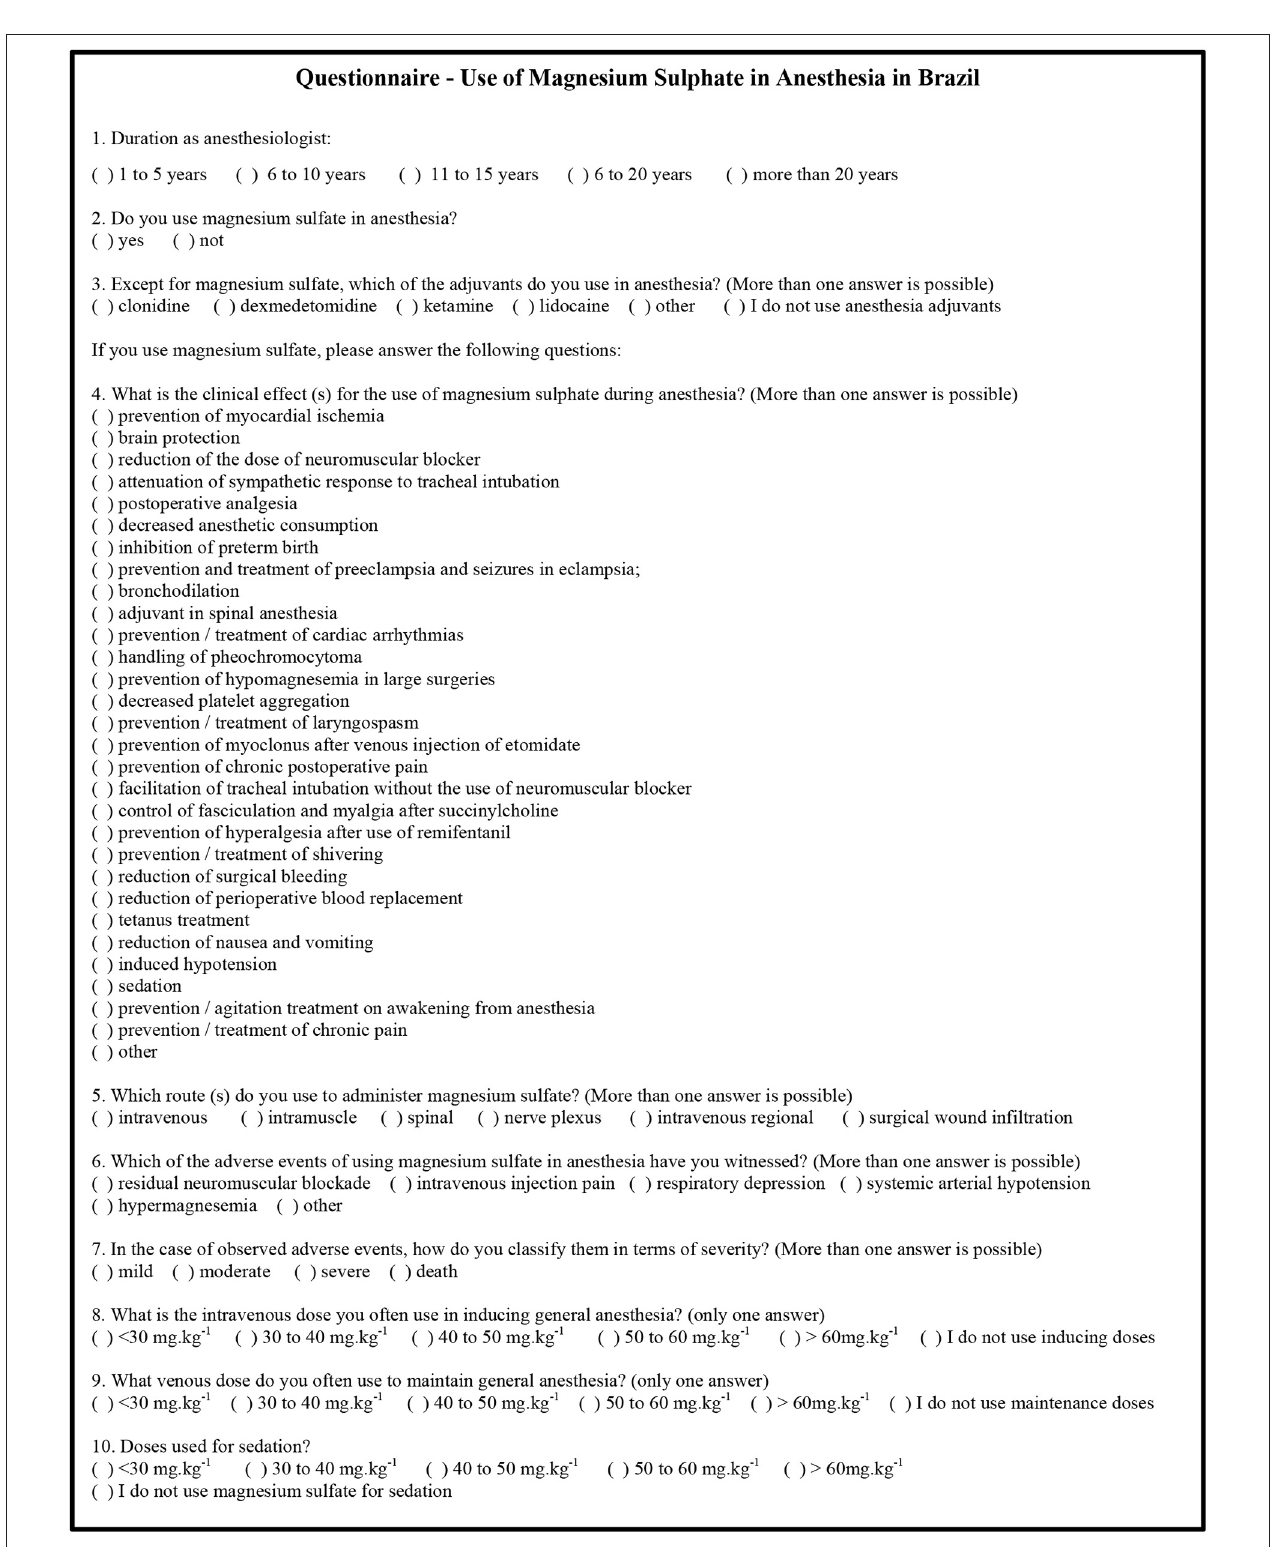
FIGURE 1 | Electronic questionnaire used in research “Use of Magnesium Sulfate in Anesthesia in Brazil.” Brazil, 2015.